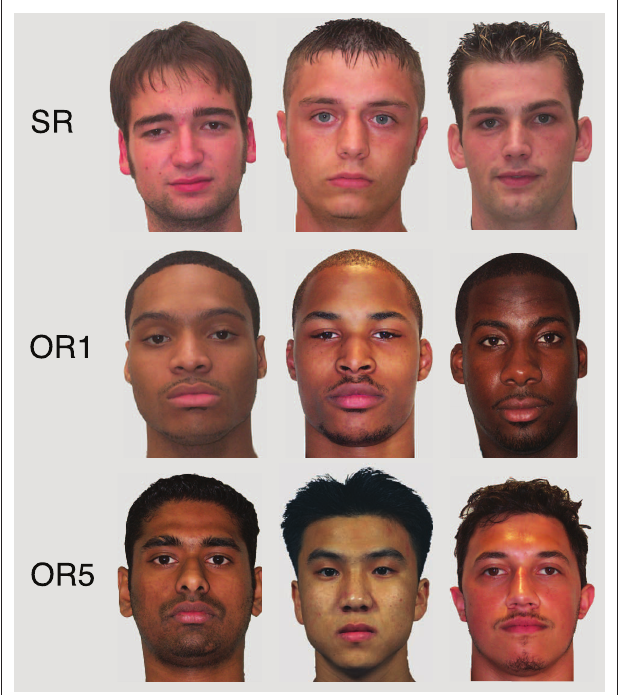
FiGuRE 1 | Sample stimuli from the SR (top), OR1 (middle), and OR5 (bottom)